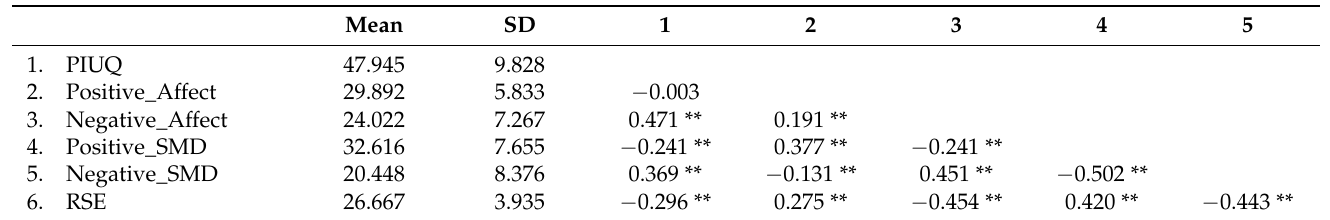
Table 2. Correlation matrix of all variables ( n = 507).